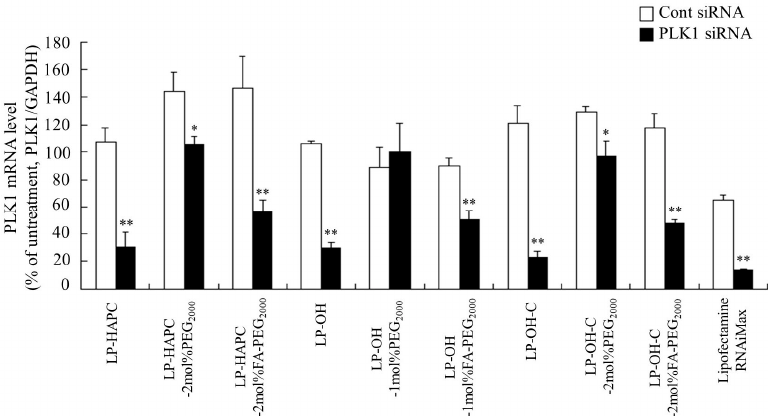
Figure 9. Effect of FA-PEG-modification of cationic liposomes on suppression of PLK1